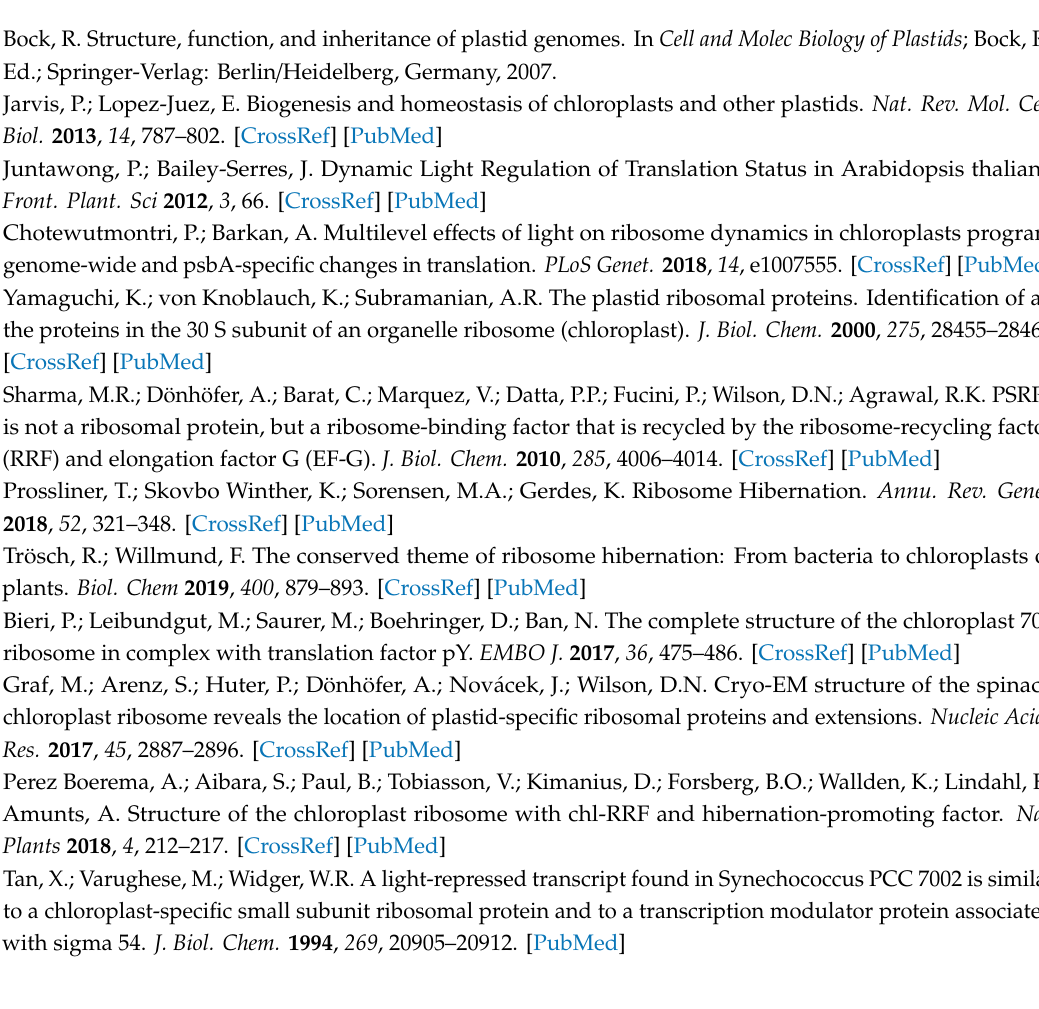
Figure S1: Images of maize psrp1 mutants in di ff erent genetic backgrounds and grown under di ff erent